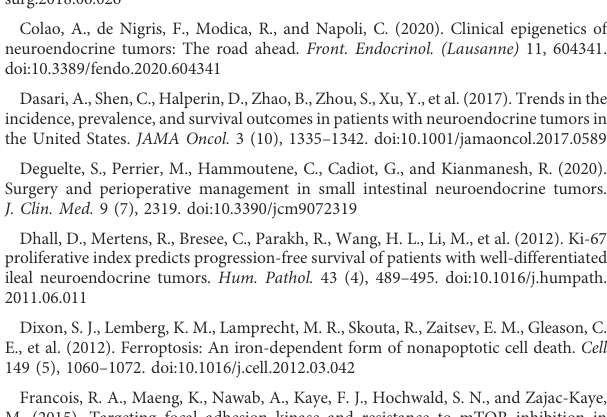
SUPPLEMENTARY FIGURE S3 ROC curves of the hub genes in GSE65286. SUPPLEMENTARY TABLE S1 List of differentially expressed genes. SUPPLEMENTARY TABLE S2 List of differentially expressed